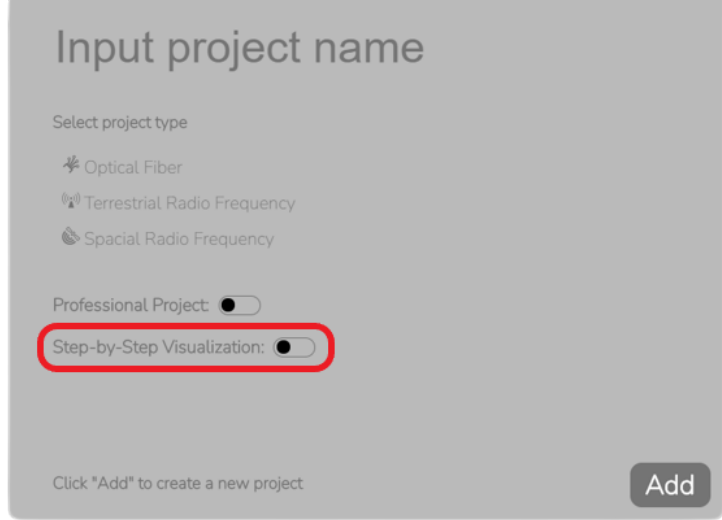
Figure 17. Step-by-step project layout